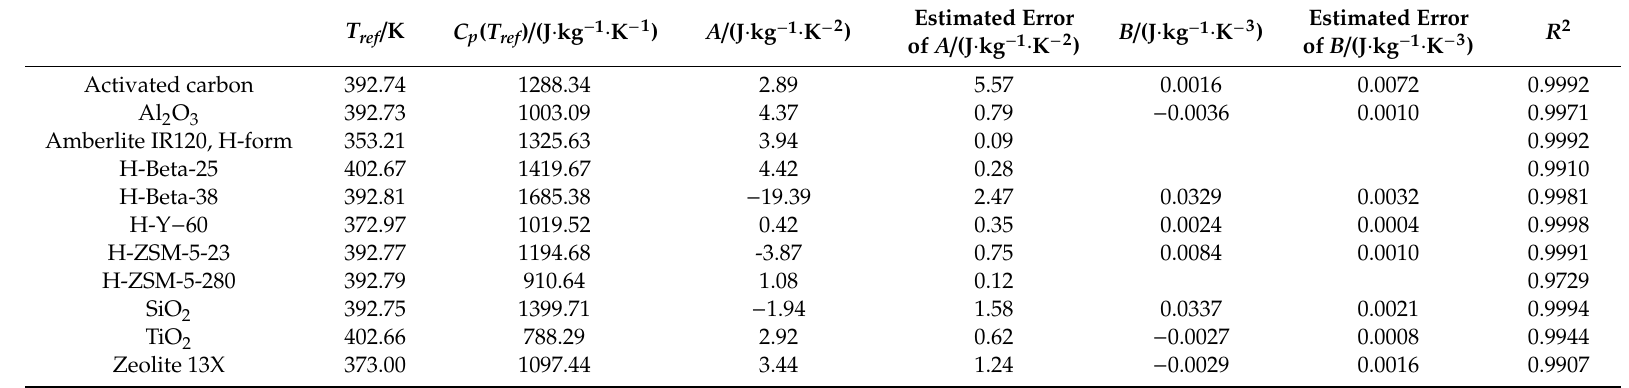
Table 4. Correlation Results of C p Data for Di ff erent Catalytic Materials with Equation